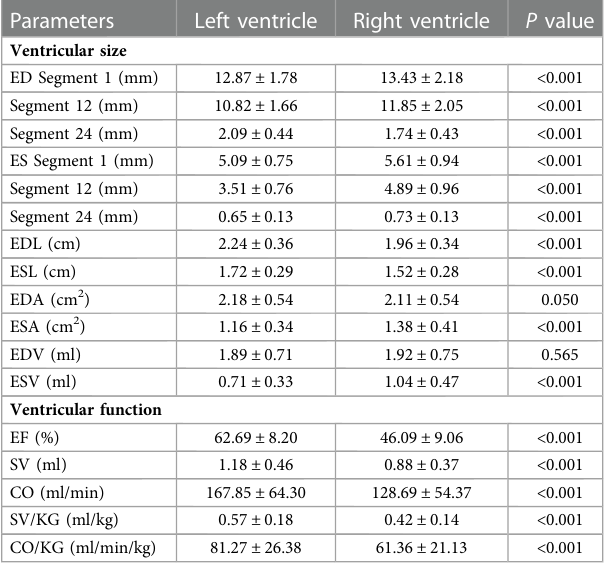
TABLE 3 Comparison of the left and right ventricular size of low-risk fetuses in the third trimester. Parameters Left ventricle Right ventricle P